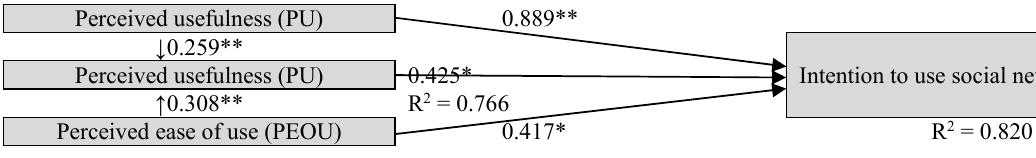
Fig. 2. Path test of the research model.